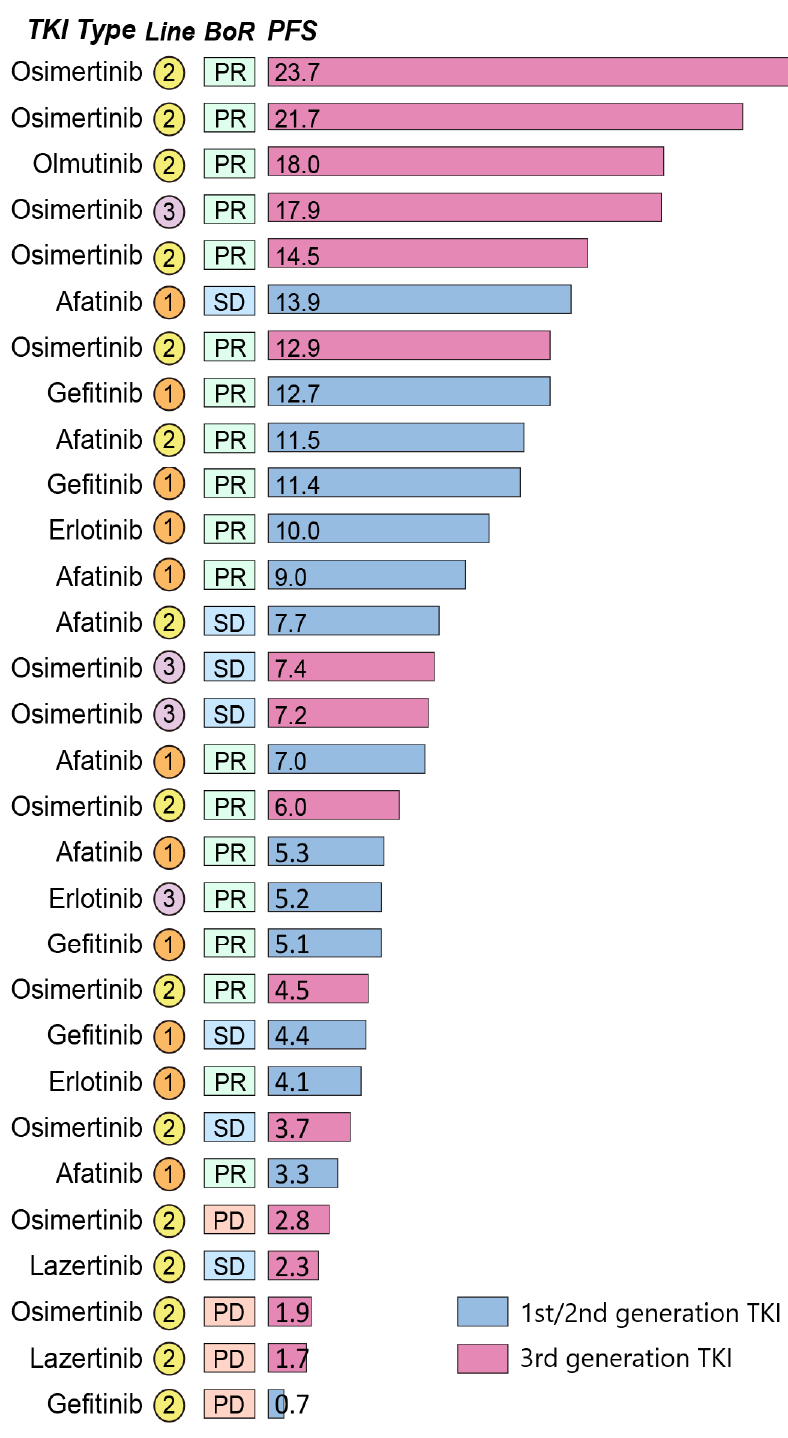
Figure 3. Treatment response with the most recent tyrosine kinase inhibitor. Response indicates the best response to the treatment. The number in the bar indicates progression-free survival in months. TKI, tyrosine kinase inhibitor; BoR, best of response; PFS, progression-free survival; PR, partial re- sponse; SD, stable disease; PD, progressive disease.